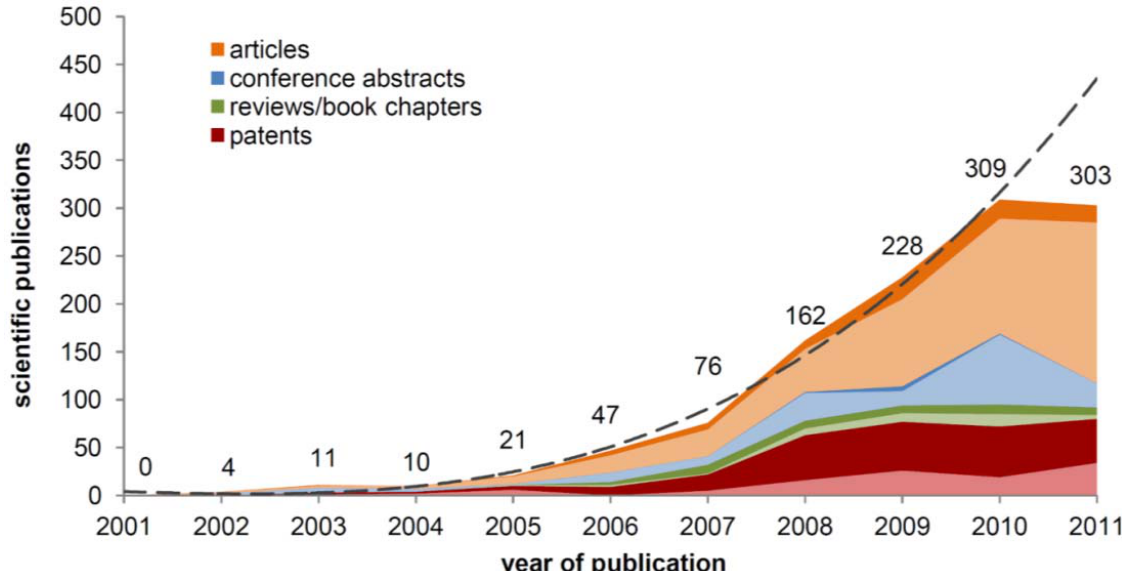
term “cellulose ionic liquids”, separated by document type (bright/dark areas correspond to articles published in English/other languages). Dotted lines represent a prognoses based on the number of total publications (excluding data for